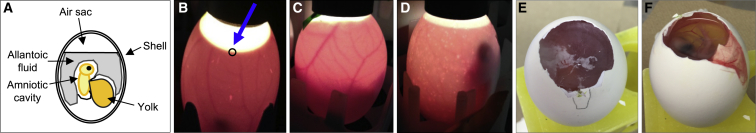
NDV Infection and Virus Harvest from Embryonated Eggs(A) Diagram of an embryonated chicken egg on day 9, showing the location of the air sac, allantoic fluid, yolk sac, and embryo. (B) Image showing the location of the air sac in a day 9 embryo when candled. The small black circle indicates where a hole should be made for the injection, at the interface between the air sac and the allantoic fluid, in a region devoid of large vasculature. (C) Example of a healthy day 11 embryo imaged 48 hr post-inoculation with low-titer NDV. Presence of healthy vasculature and movement of the embryo are signs that the embryonated egg is alive. (D) Example of a dead day 11 embryo imaged 48 hr post-inoculation with high-titer NDV. There is an absence of vasculature and no movement from the embryo. The embryo appears dark as a result of the lack of movement. (E) Embryonated egg in which the apical side of the egg has been removed using forceps and surgical scissors to reveal the chorioallantoic membrane. (F) Chorioallantoic membrane cut and peeled back to reveal the allantoic cavity from which the allantoic fluid is collected.